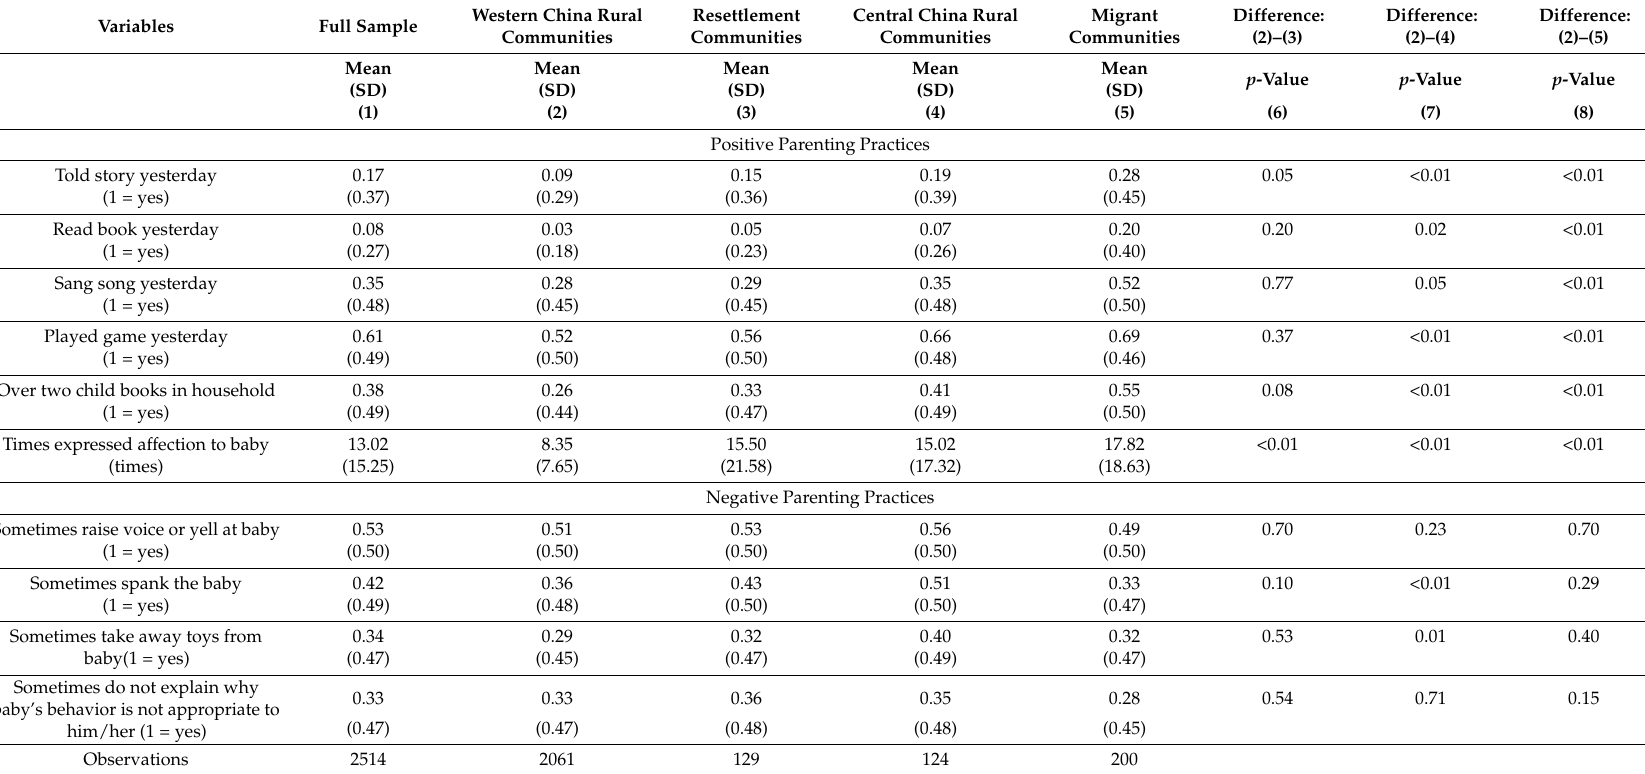
Table 4. Parenting practices across different